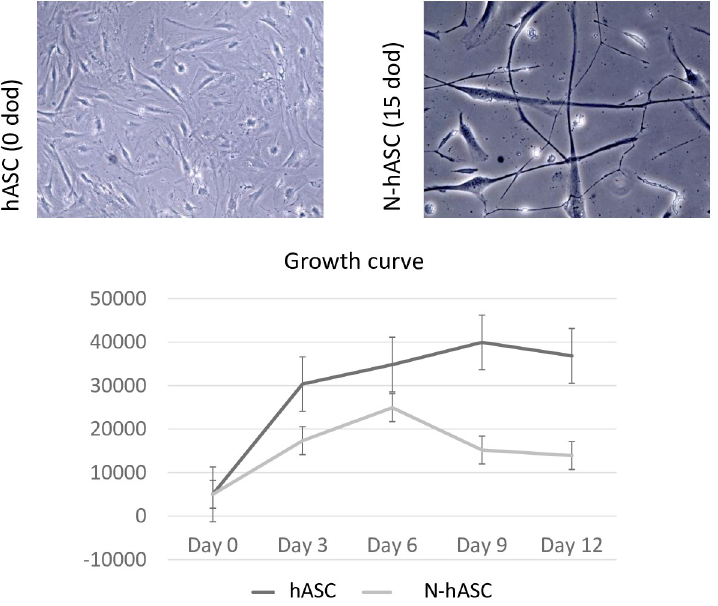
Fig 3. Representative images and growth curves of control hASCs and NhASCs. Upper panels, representative images of hASCs (left panel) and NhASCs (right panel) exposed to either standard culture media or neurobasal differentiation media, respectively, after 15 days of development. NhASCs presented lower confluence at 15 days of development through exposure to neurobasal media differentiation than hASCs on the same day of development under standard culture conditions. At the bottom, a standard growth curve conducted from 0 to 12 days suggests a lower proliferative capacity of NhASCs than of hASCs.